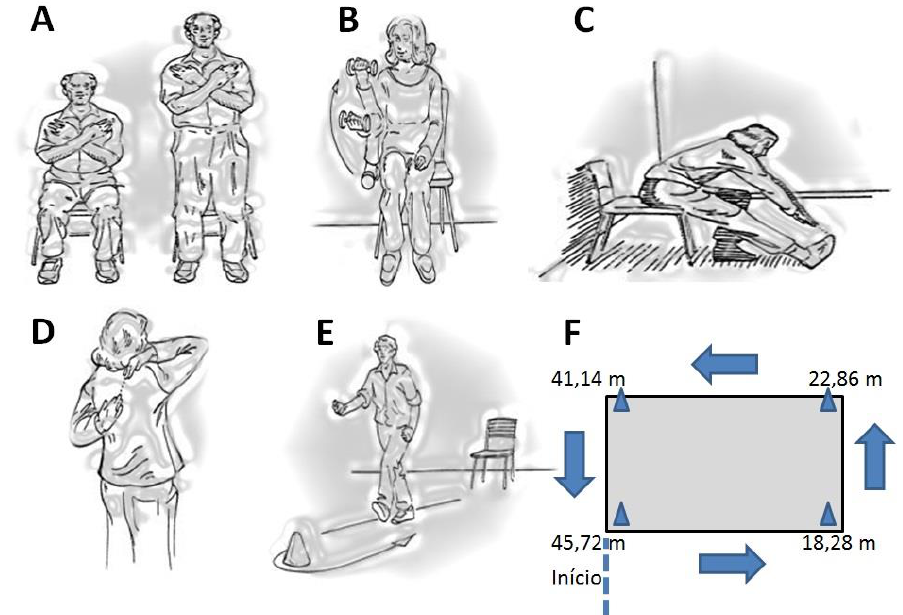
Figura 1. Testes de aptidão física para idosos. A: Força de membros inferiores (levantar e sentar na cadeira o maior número de vezes em 30 segundos); B: Força de membros superiores (flexão de antebraço com halter de 2 kg o maior número de vezes em 30 segundos); C: Flexibilidade de membro inferior (Sentar e alcançar); D: Flexibilidade de membro superior (mãos nas costas); E: Agilidade e equilíbrio dinâmico (levantar, ir e voltar o mais rápido possível um percurso de 2,5 m); F: Capacidade aeróbia (percorrer 45,72 m caminhando o mais rápido